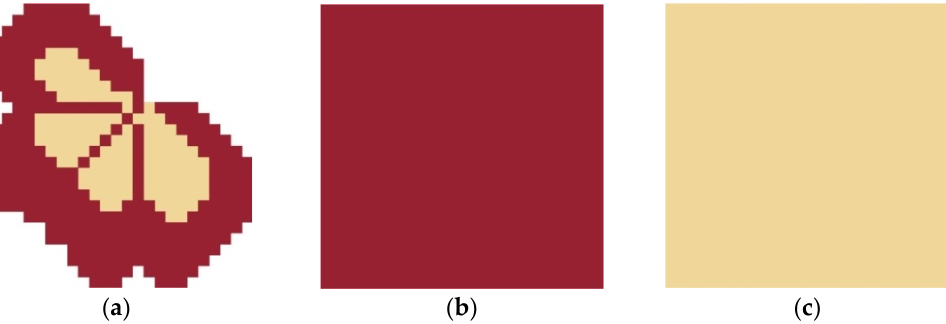
Figure 5. The digital combination for the detail of the traditional motif: ( a ) The full drawing; ( b ) The selected color for burgundy, RGB (red, green, blue) 152, 33, 49; ( c ) The selected color for beige, RGB 240, 214, 153.